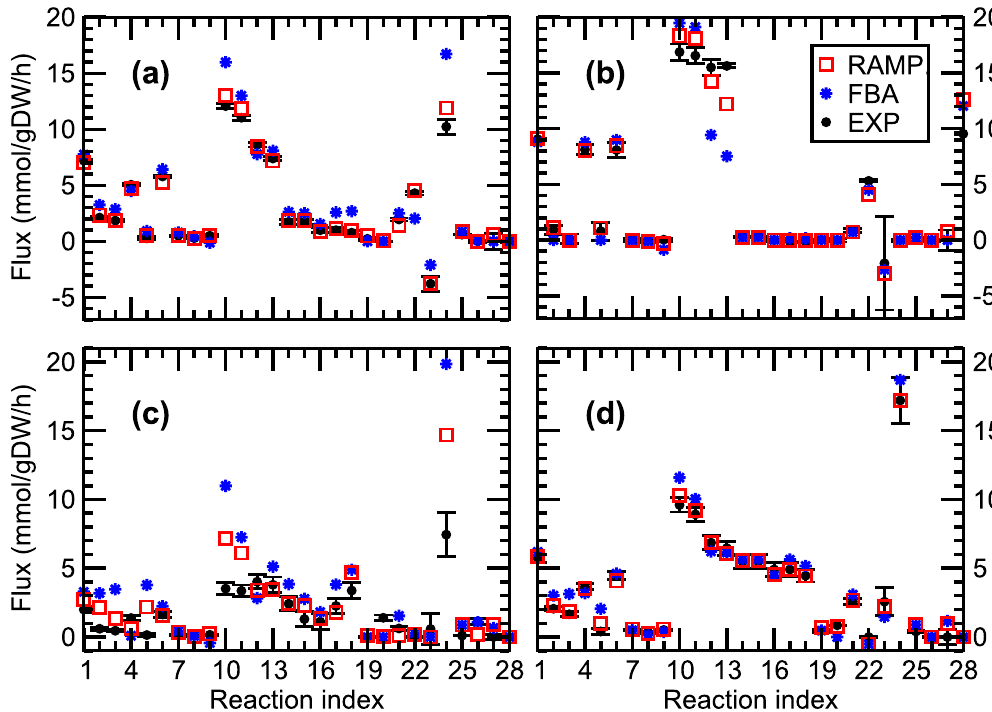
Figure 3. Comparison of experimental fluxes with RAMP and FBA predictions. Experimentally determined fluxes in E . coli (black circles with whiskers) for 28 reactions in the central carbon metabolism are compared with the predictions from FBA (blue stars) and from RAMP 3 with σ = 0.2 (red squares). All calculations are made with model iJO1366 25 . The panels correspond to experiments conducted under conditions of ( a ) aerobic batch growth 26 , ( b ) anaerobic batch growth 26 , ( c ) carbon-limited chemostat at dilution rate 0.1/h 27 , and ( d ) carbon-limited chemostat at dilution rate 0.4/h 27 . The correspondence between reaction index and biochemical reaction is given in Supplementary Table